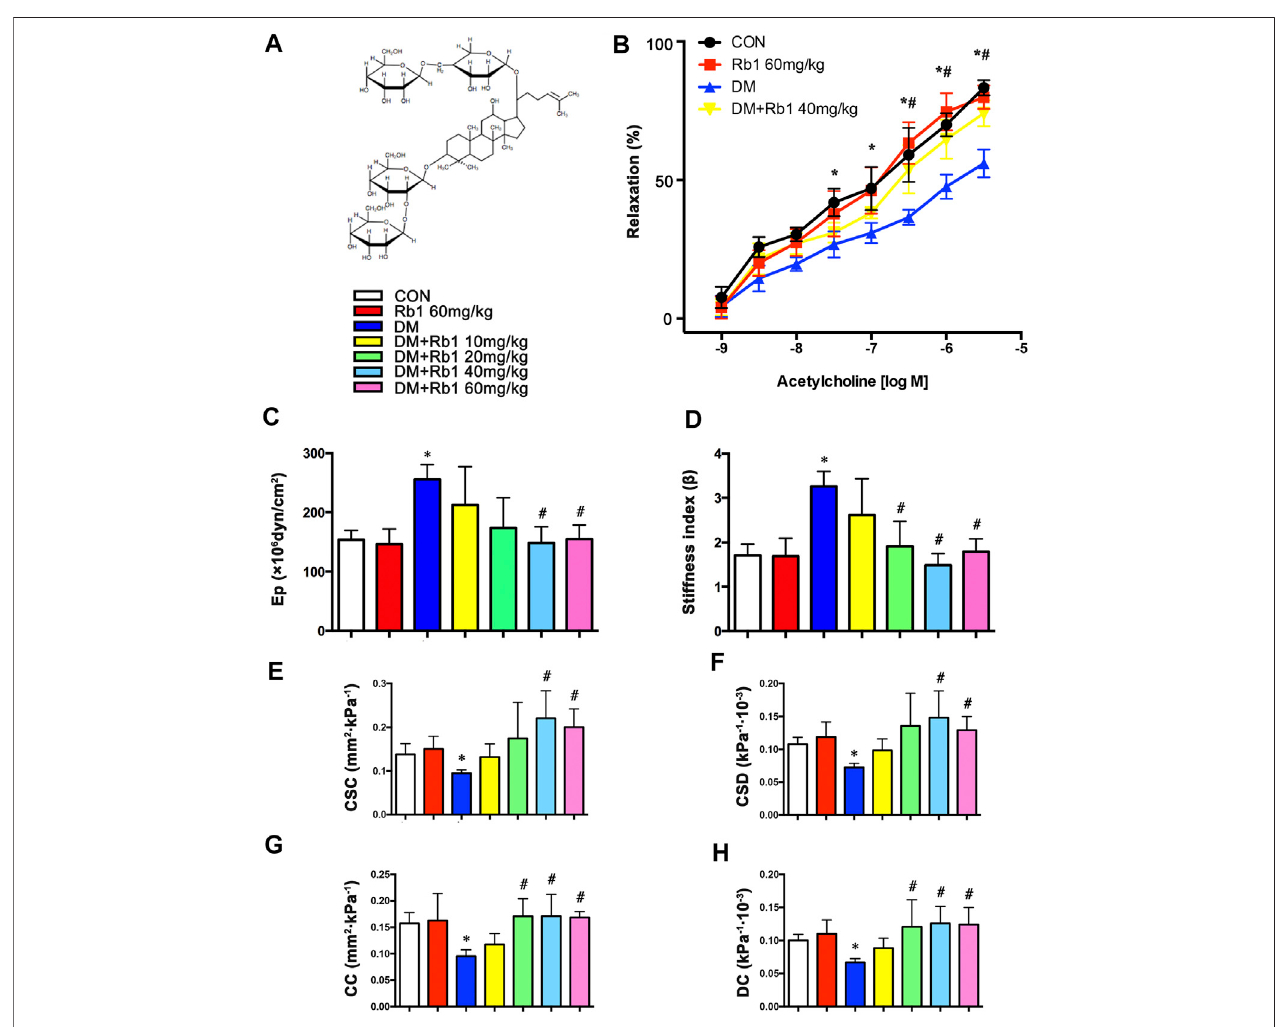
FIGURE 1 | Rb1 improves aortic compliance and restores acetylcholine-induced endothelium-dependent vasorelaxation. (A) Chemical structure of ginsenoside Rb1. (B) After the addition of phenylephrine, cumulative doses of acetylcholine (1 × 10 – 9 – 1 × 10 – 5.5 M) were added to check the endothelial functions. (C) Peterson ’ s elastic modulus (Ep). (D) Arterial stiffness index ( β ). (E) Cross-sectional compliance (CSC), (F) cross-sectional distensibility (CSD), (G) compliance coef fi cient (CC), and (H) distensibility coef fi cient (DC). Data are mean ± SEM. n (cid:2) 5 – 6, * p < 0.05 vs. Control; # p < 0.05 DM + Rb1 vs. DM.